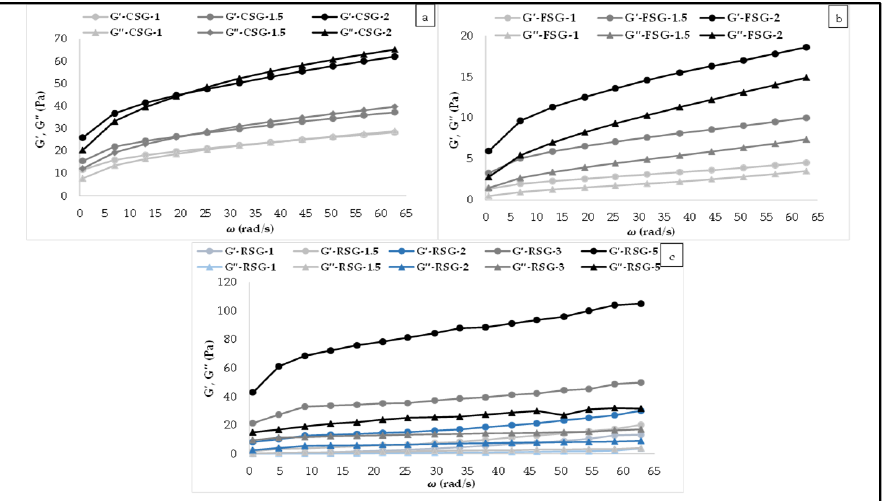
Figure 6. Viscoelastic behavior of the ( a ): CSG: chia seed byproduct gum (1–2%), ( b ): FSG: flaxseed byproduct gum (1–2%), ( c ): RSG: rocket seed byproduct gum (1–5%) solutions with different concentrations. Non-linear regression was used to analyze experimental G (cid:48) and G (cid:48)(cid:48) values vs. ω , and the computed magnitudes of slopes (n (cid:48) and n (cid:48)(cid:48) ), intercept (K (cid:48) and K (cid:48)(cid:48) ), and coefficient of determination (R 2 ) values are shown in Table 5. K (cid:48)(cid:48) values were determined to be higher than K (cid:48) values, indicating that gum solutions exhibited liquid-like characteristics. Similar results were reported in previous studies on different gum solutions [66–68] and